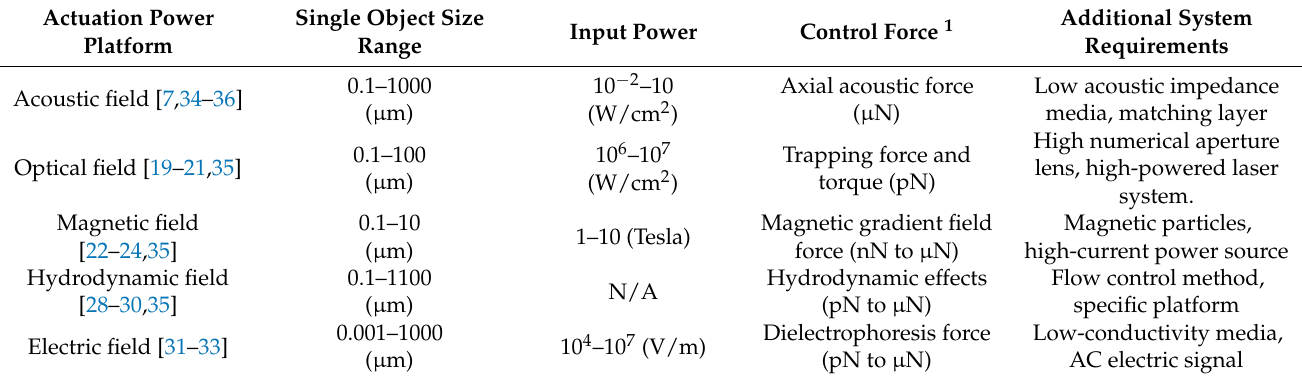
Table 1. Summary of external powered platforms for wireless particle